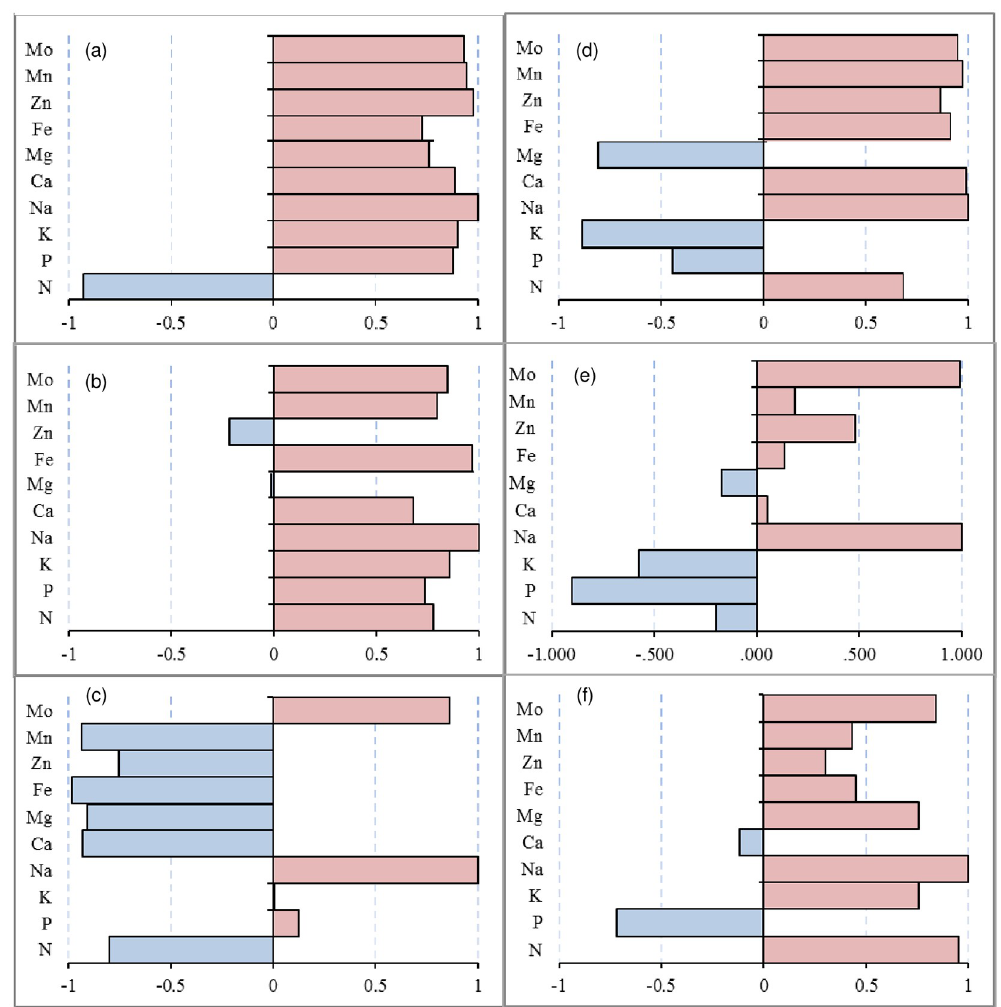
Fig 3. Correlation between the concentration of Na and other elements in leaves, stem, and root of two cotton varieties (salt-tolerant variety L24, salt-sensitive variety G1) under saline stress. (a), (b), and (c) stand for the leaves, stem, and root of L24, respectively; (d), (e), and (f) stand for the leaves, stem, and root of G1, respectively.